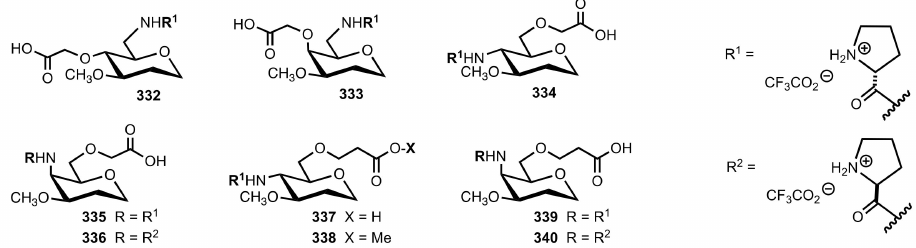
Figure 25. Other sugar D - and L -prolinamide organocatalysts prepared by Mart í n and